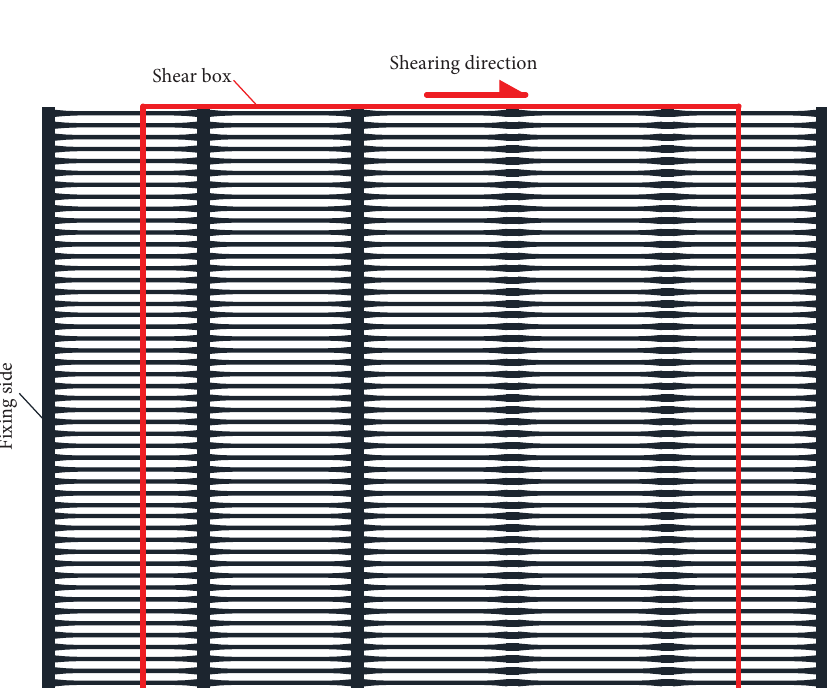
Figure 6: Geogrid with 50% cross